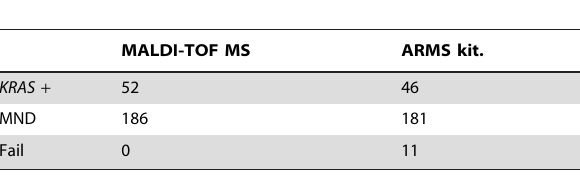
Table 3. Number of KRAS mutations detected vs. mutation not detected (MND) and fails by both